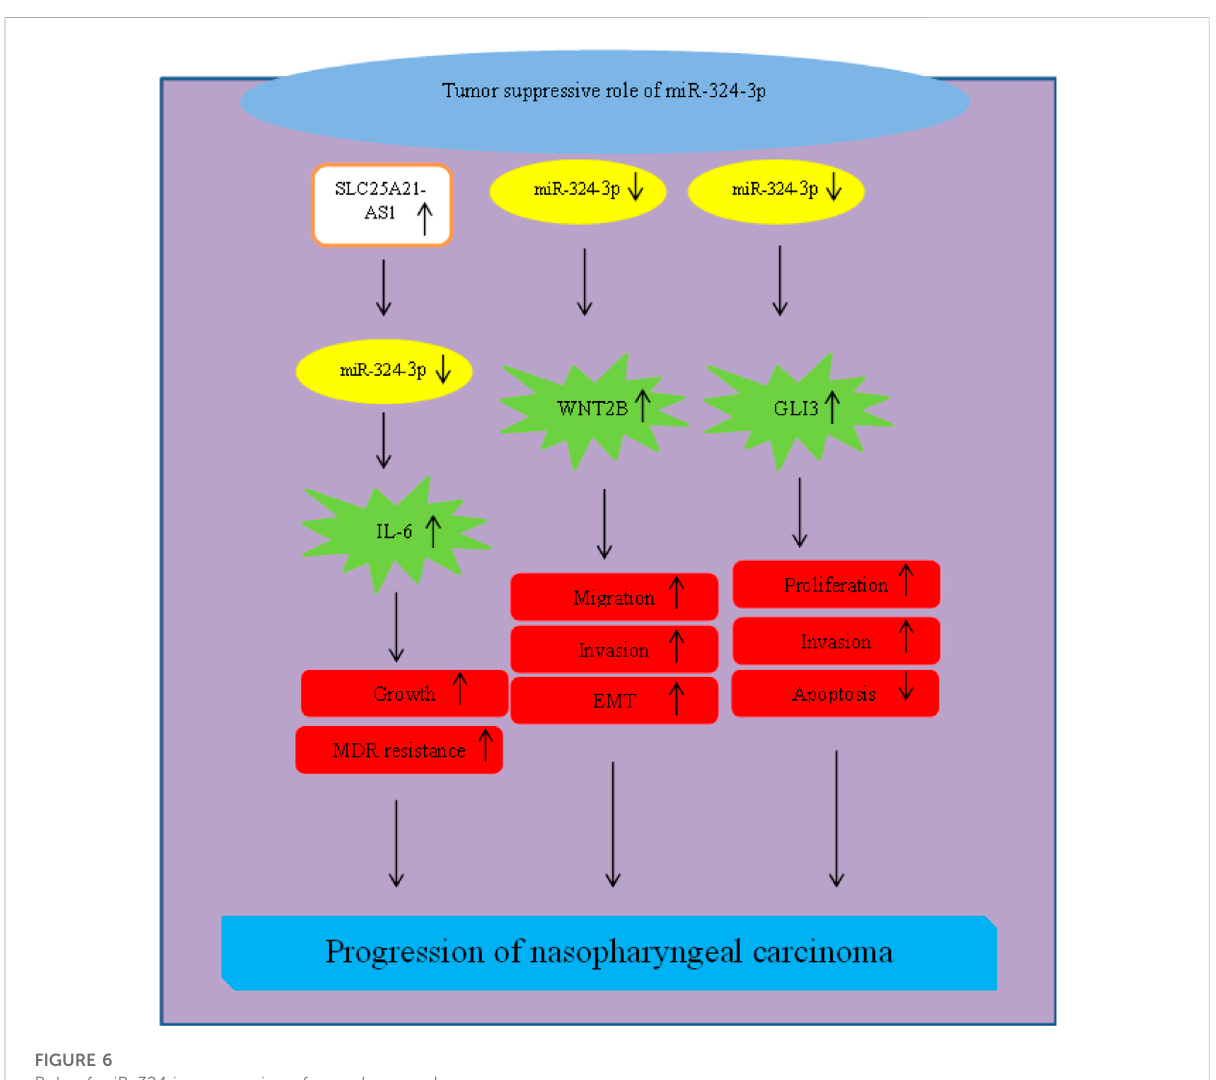
FIGURE 6 Role of miR-324 in progression of nasopharyngeal